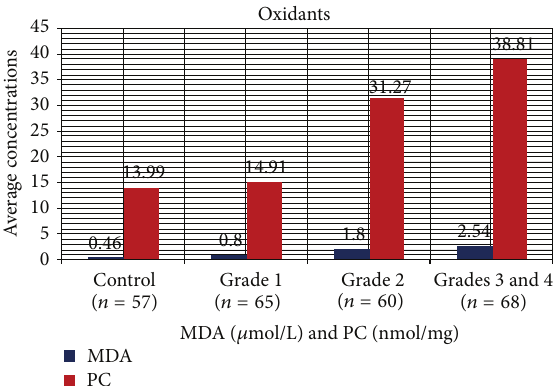
Figure 1: Anthropometric measurements in cases of PEM and Control. Results are expressed as mean ± S.D. 𝑃 < 0.01 for Wt. and 𝑃 < 0.001 for MAC while comparing Wt. and MAC of PEM (cases) with control by ANOVA test.